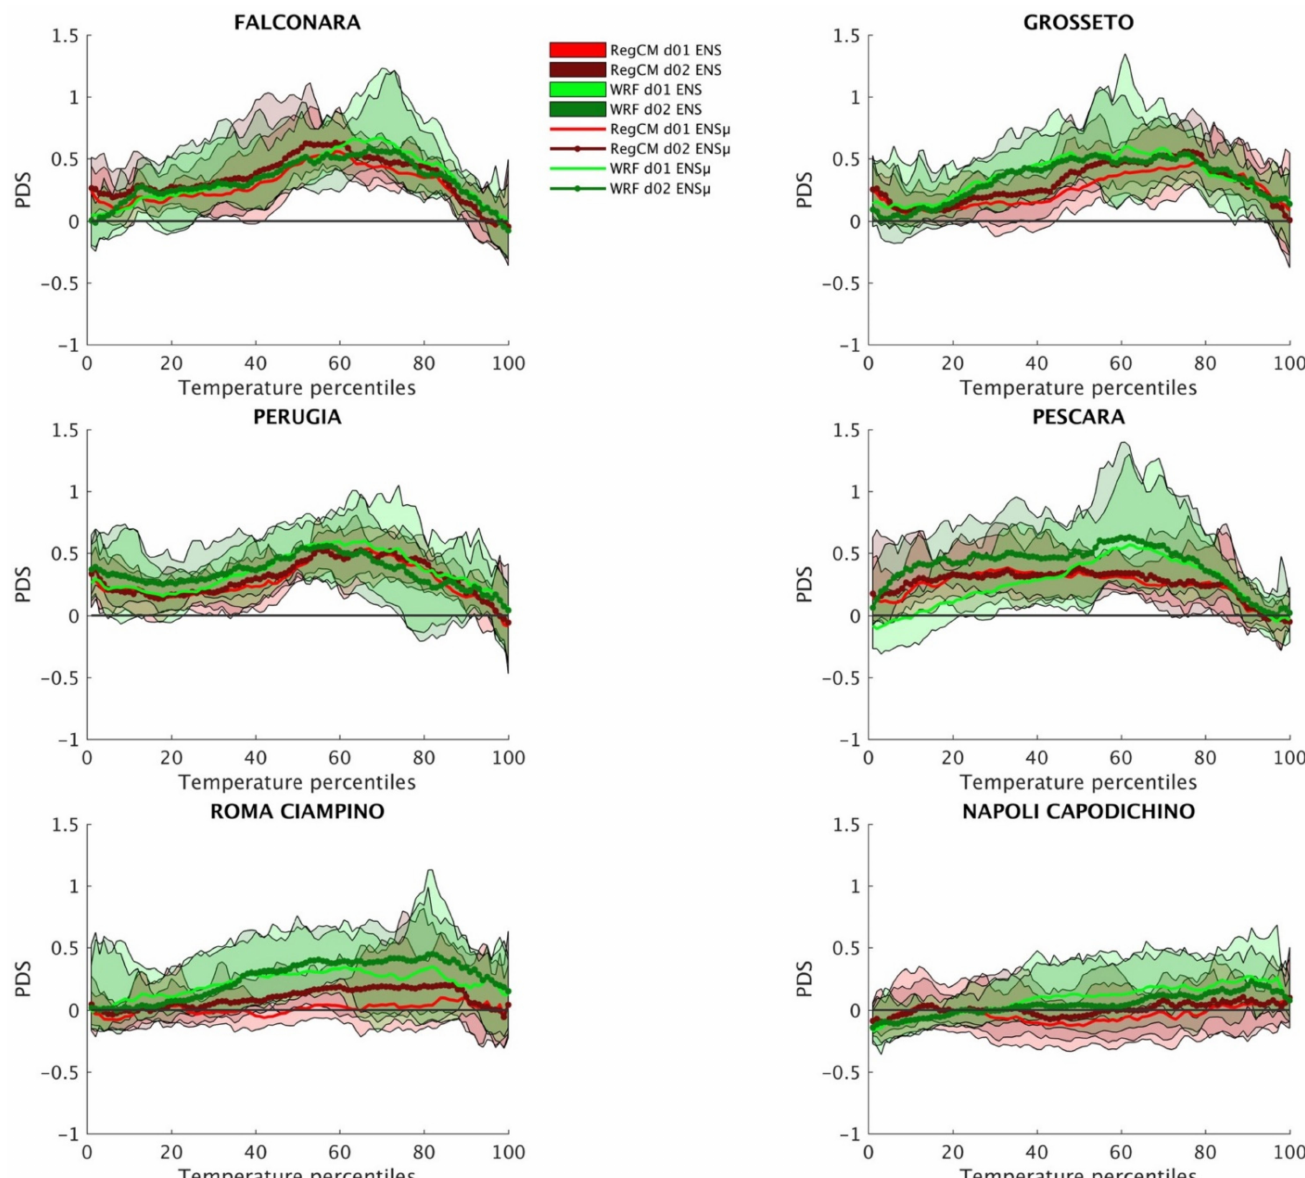
Figure 10. Same as Figure 9, but for the temperature percentile-based Downscaling Signal